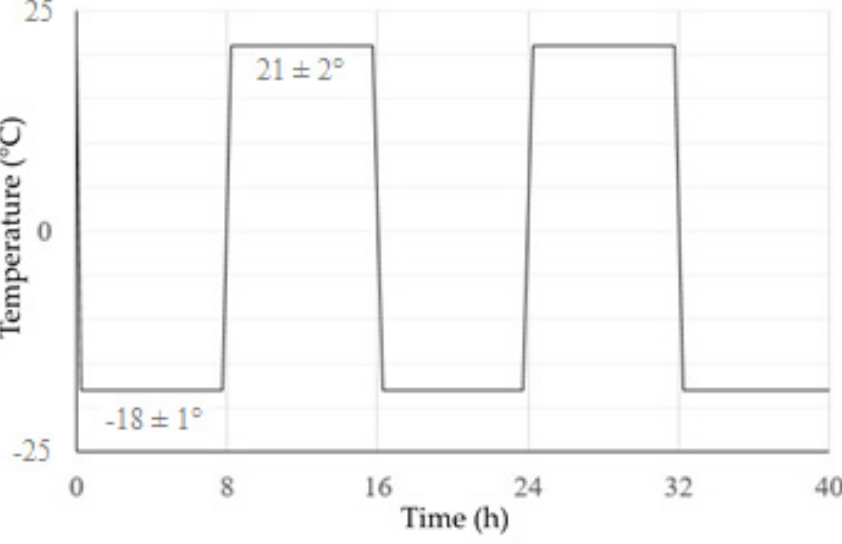
Figure 5. Schematic of the temperature cycling process.